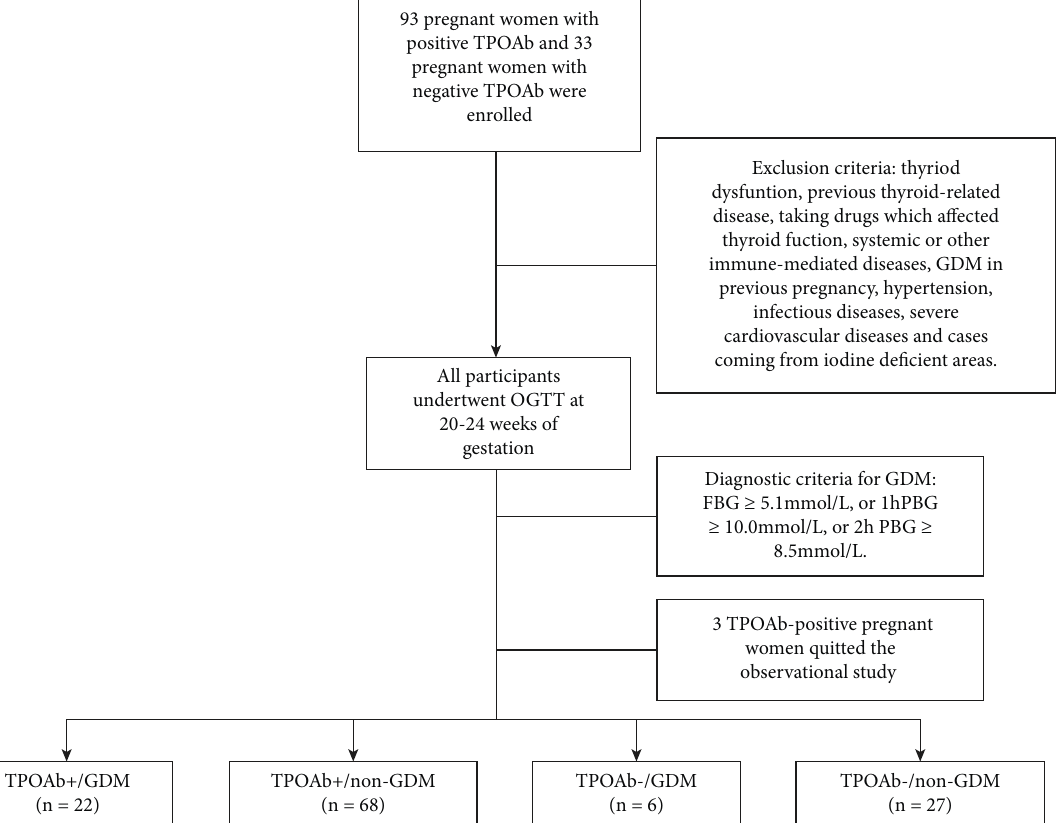
Figure 1: Flow diagram of the study